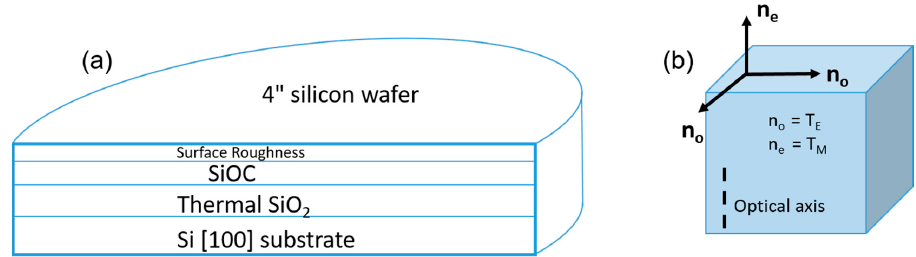
Figure 1. ( a ) Four-layer optical model employed to retrieve optical constants of SiOC film from ellipsometric data—not to scale, ( b ) schematic of SiOC anisotropic layer with optical axis perpendicular to surface and ordinary n o and extraordinary n e refractive indices.